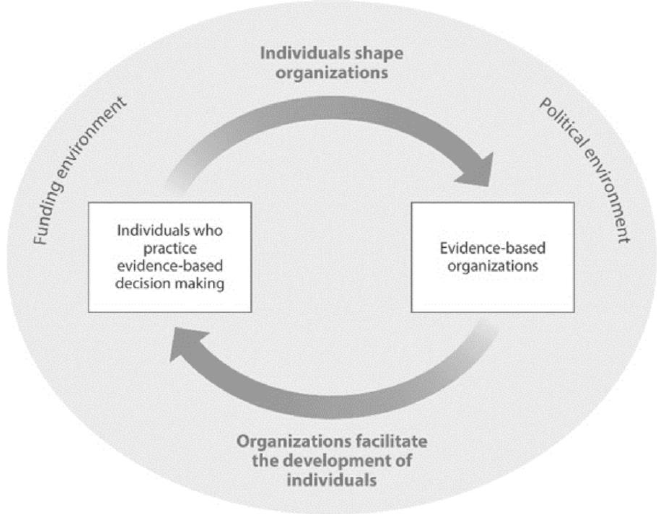
Figure 2. Relationships between people and organizations in public health decision making (Re- printed from The Relationships Between State Health Department Practitioners ’ Perceptions of Or- ganizational Supports and Evidence-Based Decision-Making Skills. Public Health Reports (1974), Mazzucca, S. et al. (2021), Copyright (2021), with permission from SAGE Publications,